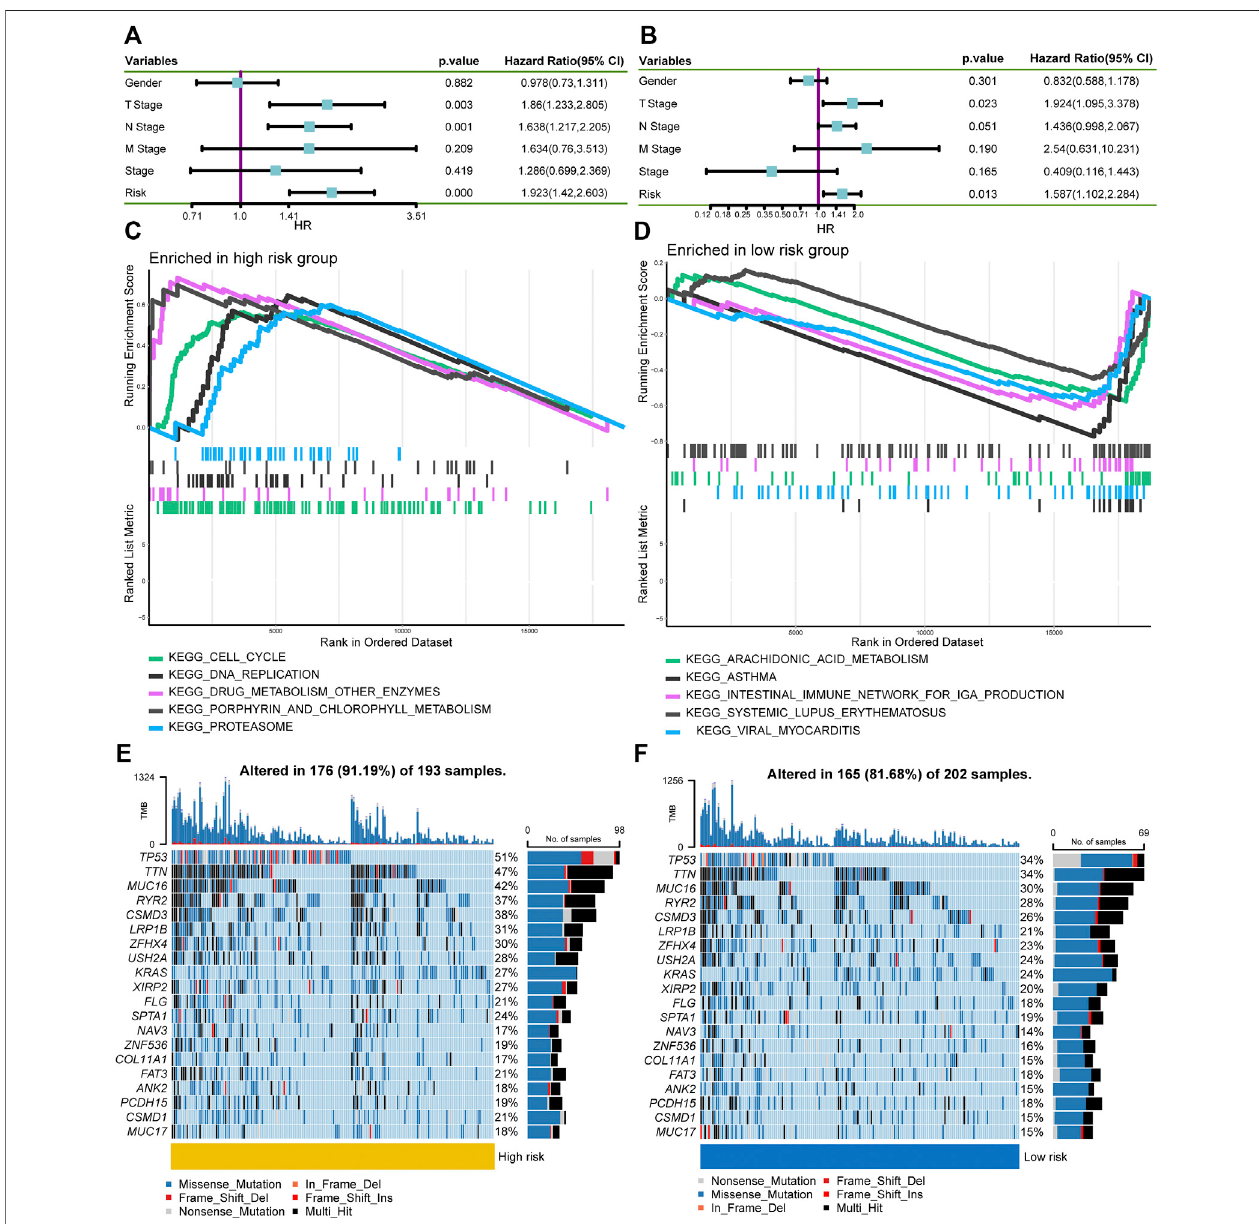
FIGURE 6 | Independent prognostic ability evaluation, pathway enrichment analysis, and gene mutation landscape analysis. (A,B) The univariate and multivariate Cox regression analysis demonstrates the risk score ’ s independent prognostic ability. (C,D) GSEA to investigate the biological processes and pathways enriched in high- and low-risk groups. (E,F) Waterfall plots summarize the gene mutation landscape in high- and low-risk groups. GSEA, Gene Set Enrichment Analysis.